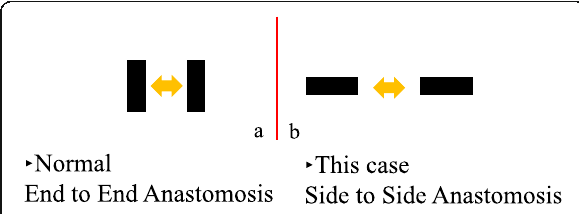
Fig. 1 Scheme of adsorption of the two magnets. a Normal case: adsorption in the end-to-end direction. b This case: adsorption in the side-to-side direction